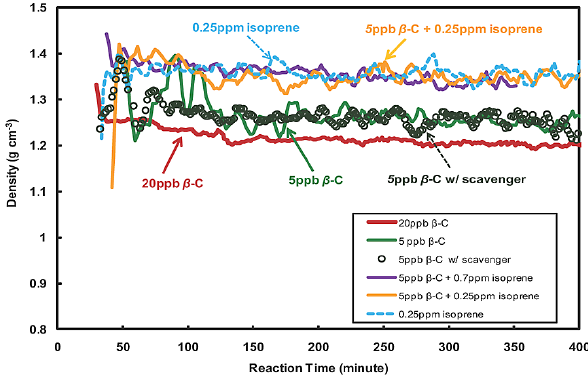
Fig. 1. Particle density, ρ a (gcm − 3 ), as a function of reaction time. In each reaction, ozone was the oxidant and no OH scavenger was present unless specified (e.g., 5ppb β -C w/